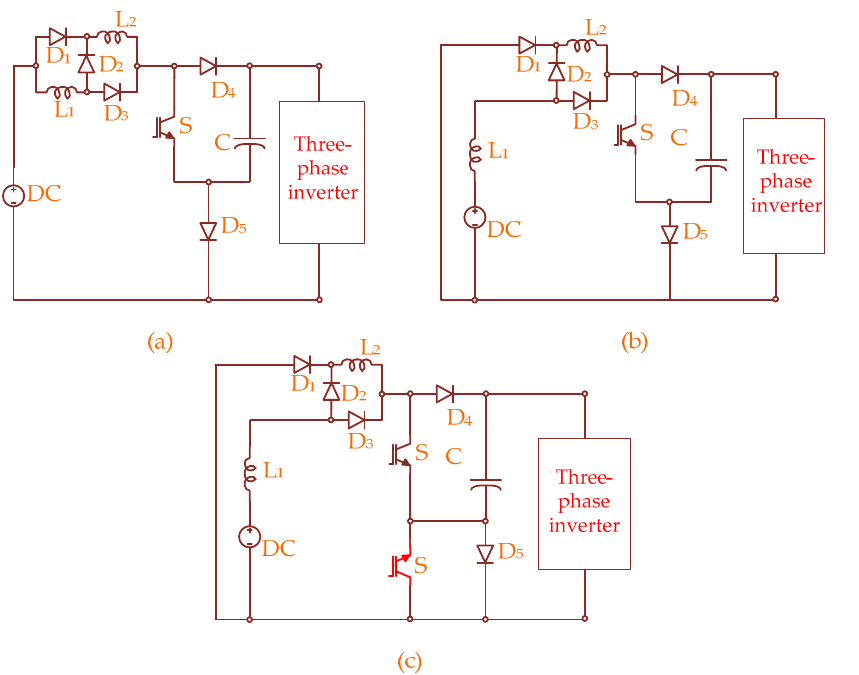
Figure 7. Switched-inductor derived quasi-switched boost inverter topologies. ( a ) Switched-induc- tor qSBI (SL-qSBI); ( b ) Improved switched-inductor qSBI (cSL-qSBI); ( c ) Modified improved switched-inductor qSBI(cSL-qSBI).